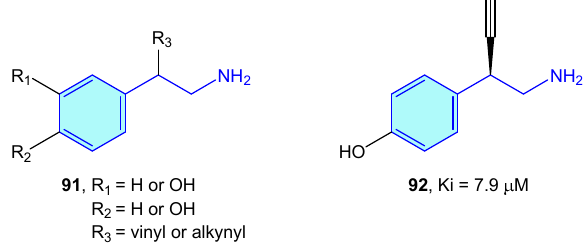
Figure 9. 2-Phenylethyl-based DBH ligands by Kruse et al [141].